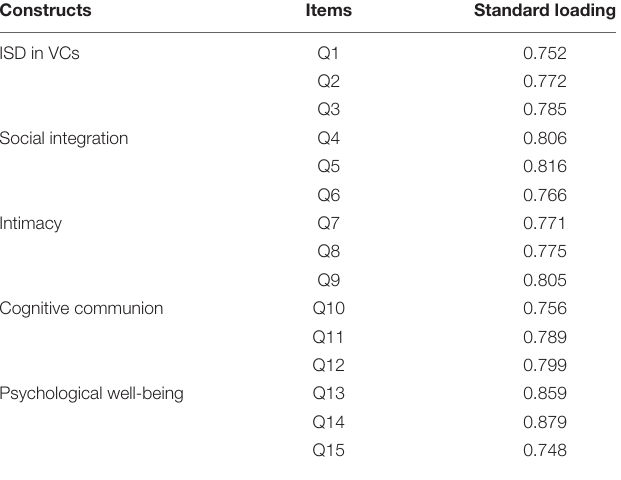
TABLE 3 | Measurement loading.